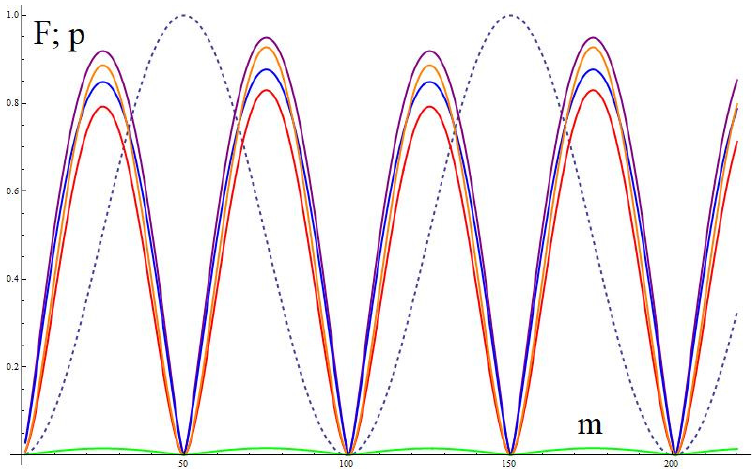
Figure 1. Parameters N = 2 12 , p = 1/ N , Success probability: Blue dashed line, Entropies: von Neumann: Red line r = 2; Orange line r = 3, Renyi: Blue line r = 2, a = 0.7; Purple line r = 3, a = 0.7, Concurrency C 1,1 : Green